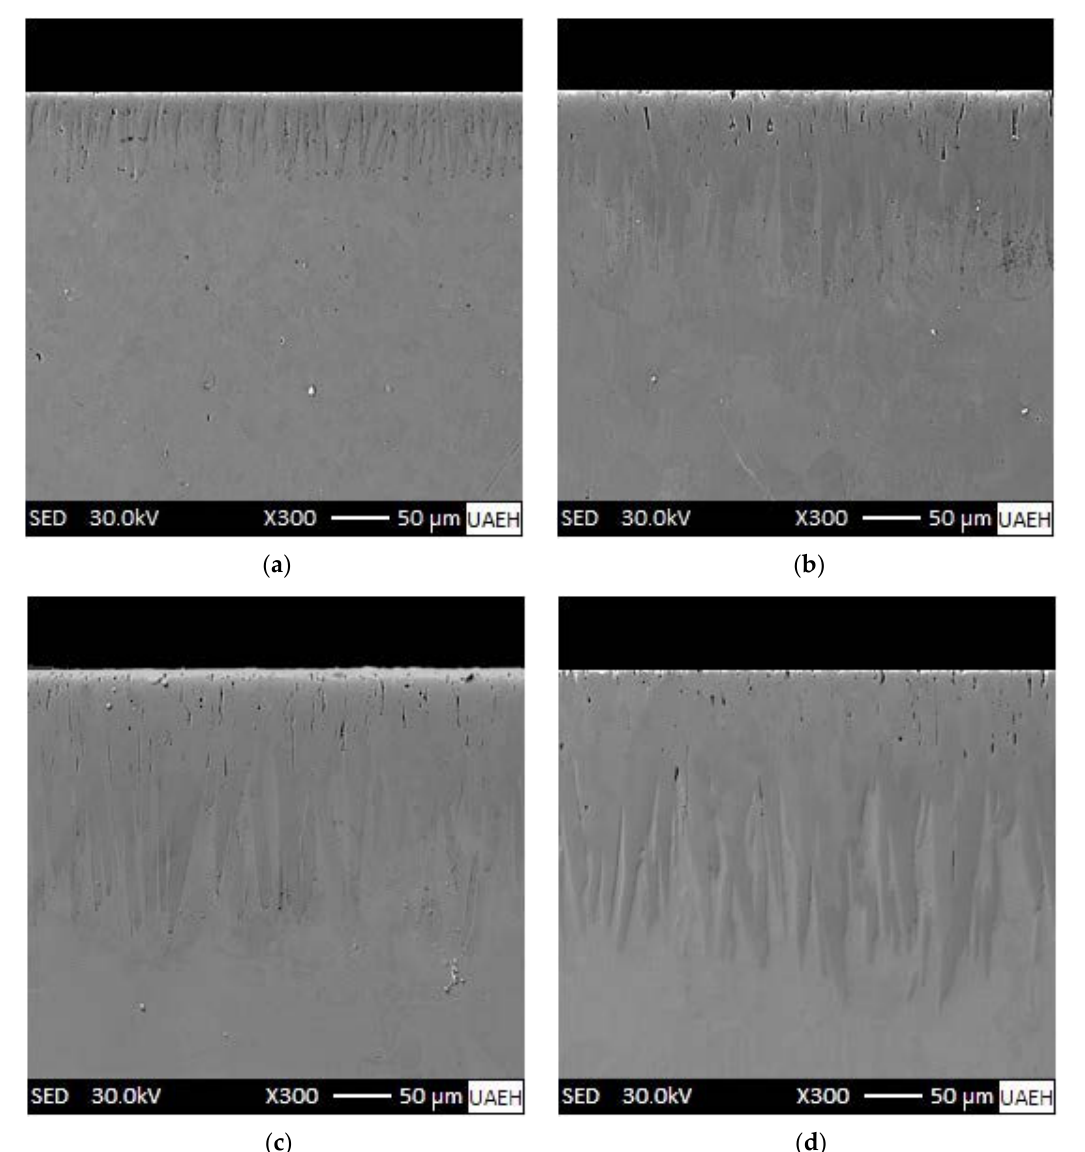
Figure 6. Scanning electron microscopy (SEM) images of the borided samples from ASTM A283 under the following conditions: ( a ) 1223 K for 2 h, ( b ) 1223 K for 4 h, ( c ) 1273 K for 6, and ( d ) 1273 K for 8 h.